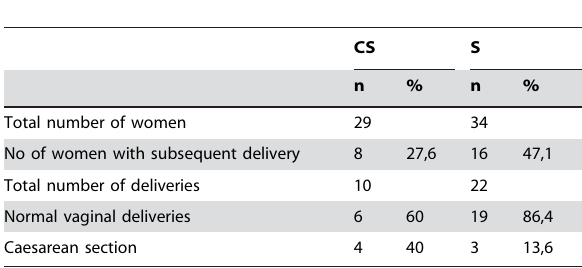
Table 4. Outcome of subsequent deliveries after CS and S.